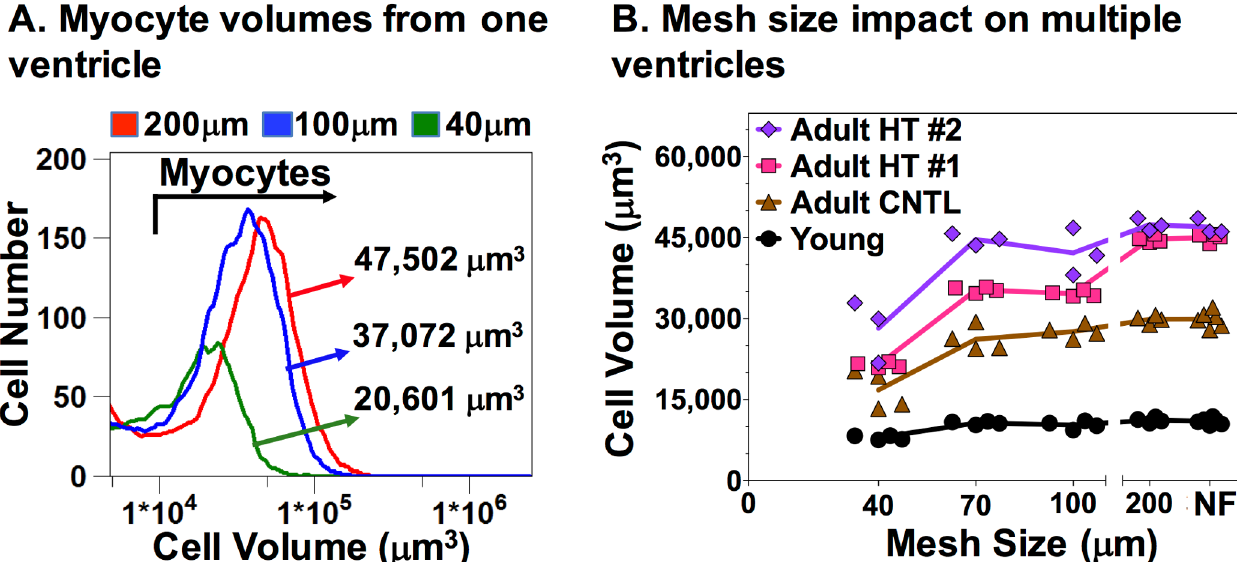
Fig 1. Mesh size and myocyte volumes. A, Ventricularmyocytes (VMs) were obtainedfrom an adult New ZealandWhite rabbit with cardiac HT (Adult HT#2). Three aliquots of cardiaccells in suspension were filtered through three different mesh sizes (40, 100, or 200 μ m)prior to sizing with a Coulter Multisizer. Cell volume distributionsare plotted againstcell numbers. The arrow in the plot shows the VM gate used for analysis; counts to the left are debris. 4000–7000VMs were gated to calculate the median cell volume. Specific volumes for each mesh are noted in the plot. B, Myocyte volumes from four different rabbits (young, adult control (CNTL), and adults with cardiac hypertrophy (Adult HT #1 & 2)) were measured in replicates as shown in Panel A. Three to six aliquots from each ventricular sample were either not filtered (NF) or filtered through one of four mesh sizes (40, 70, 100, or 200 μ m)in multiplereplicates. The mesh sizes are plotted on the x-axis starting with the NF samples (right to left). The median volumesof NF VMs increasedsubstantially from young VMs (11,017+542 μ m 3 , 1.0-fold) to NF CNTL VMs (29,932+1,356 μ m 3 , 2.7-fold) to hypertrophicVMs (45,961+966 μ m 3 , 4.2-fold (n = 2). Each animalis color coded, and each mesh size has multiplereplicates. Replicatedata points are staggered at each mesh size to depict intra sample variance.Inflection points in the lines represent the mean value for each mesh within each animal